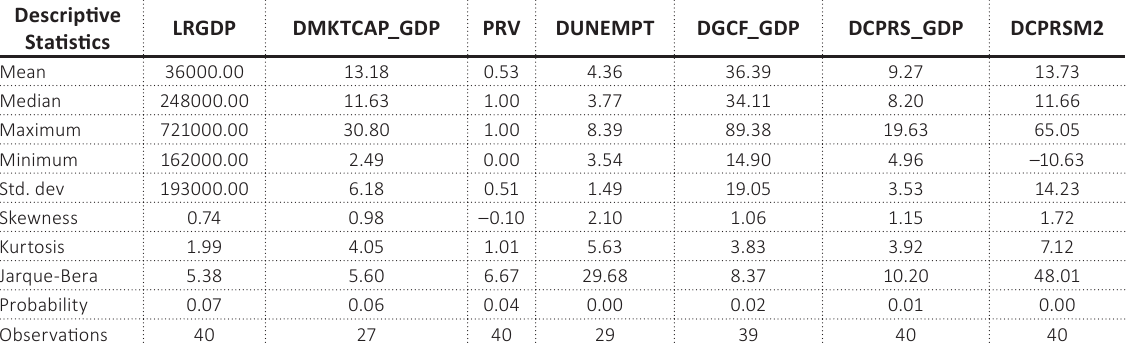
Table 1. Summary statistics of the model variable